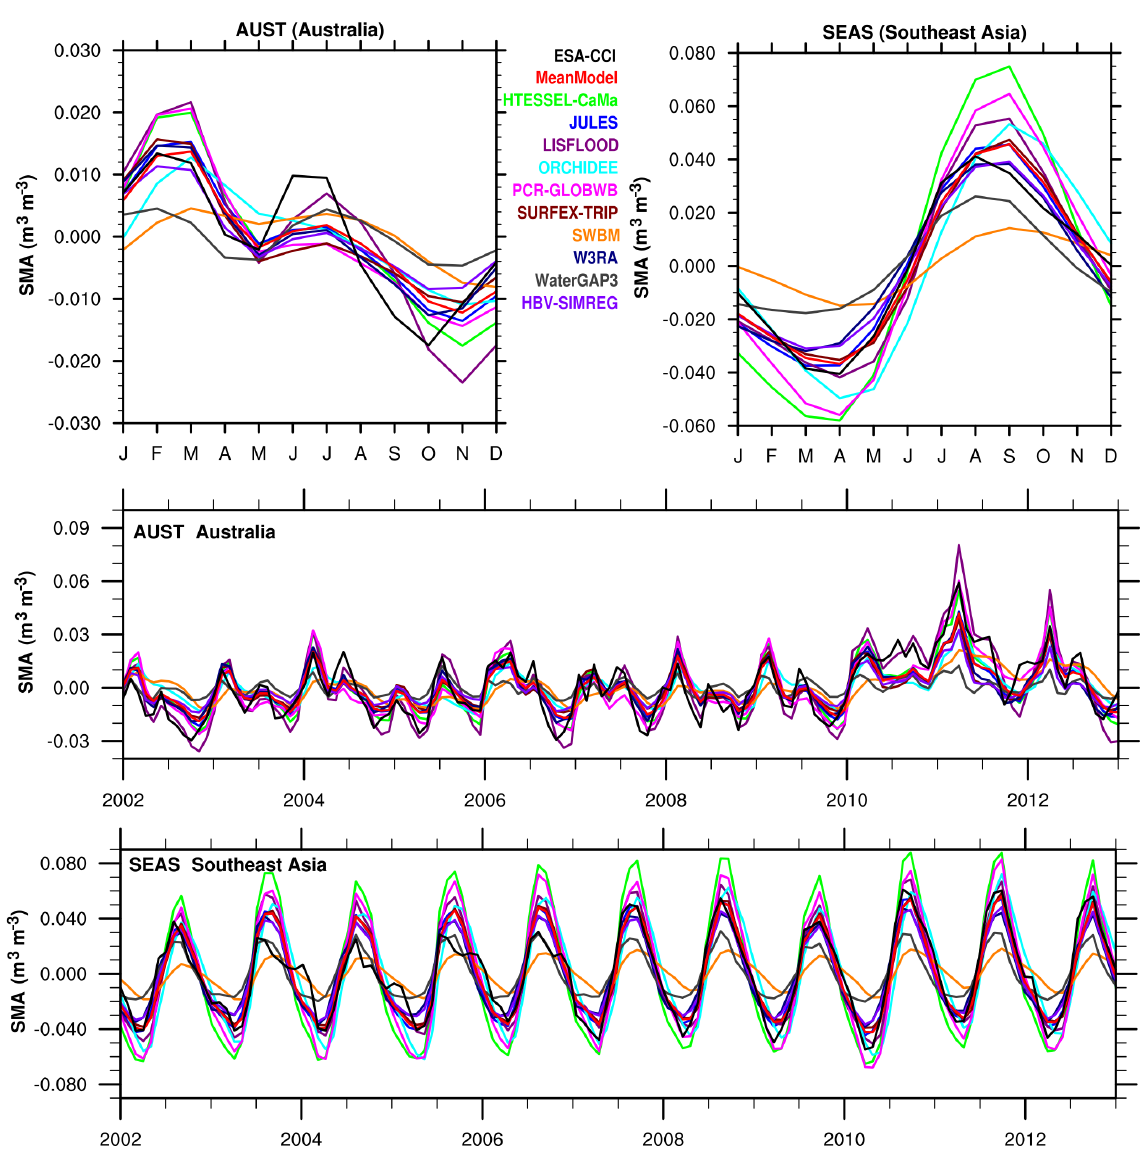
Figure 8. Soil moisture anomaly dynamics and climatology over Australia and Southeast Asia for all models compared to ESA CCI